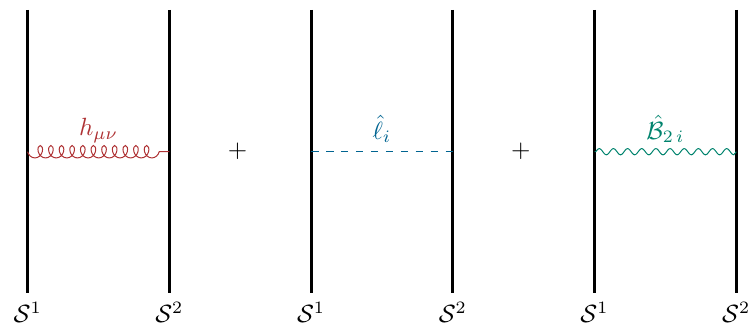
Figure 8 . The mutual interactions of two parallel strings mediated by the graviton h µν , dual saxions ˆ ‘ i and gauge two-forms ˆ B 2 i